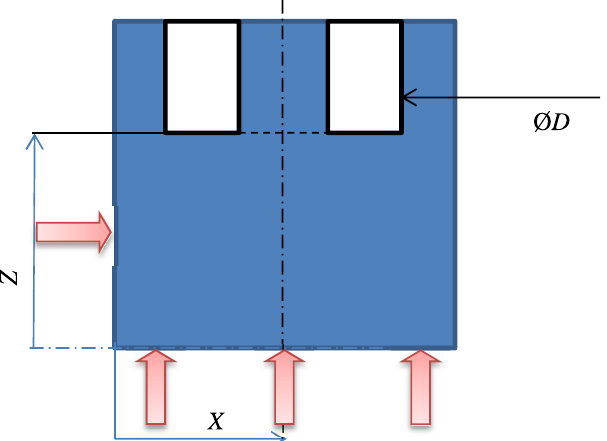
Fig. 3. Parameter Z of the height of the circular groove (front view in section).